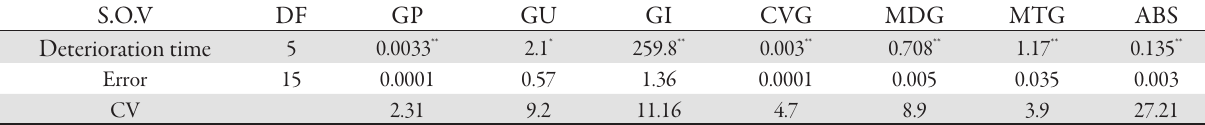
Tab. 1. Analysis of variance for deterioration effect on soybean seeds germination indexes